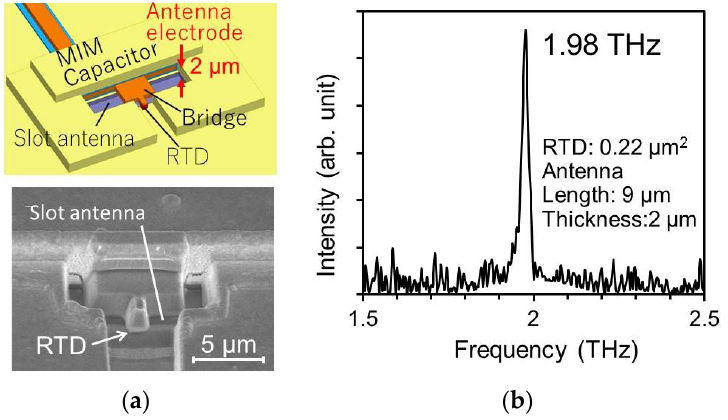
Figure 4. RTD oscillator with thick antenna electrode. Copyright (2017) IEEE. Reprinted with permission from [32]: ( a ) Structure of the oscillator, and ( b ) oscillation spectra.